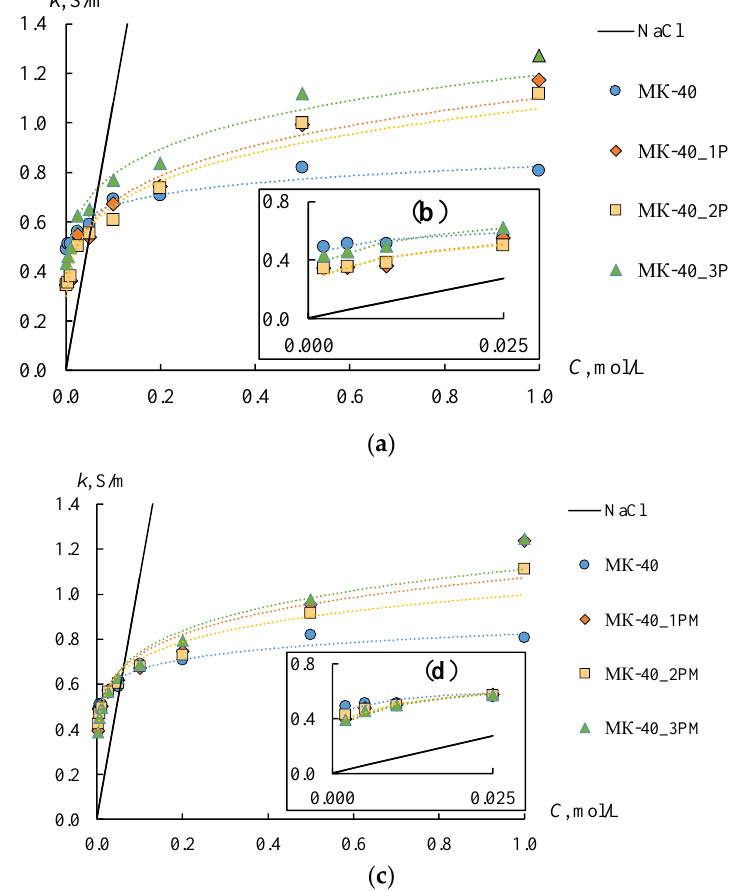
Figure 10. Concentration dependences of conductivity ( a , c ) and their initial sections ( b , d ) for smooth, profiled ( a , b ) and bilayer profiled ( c , d ) MK-40 membranes in NaCl solutions.